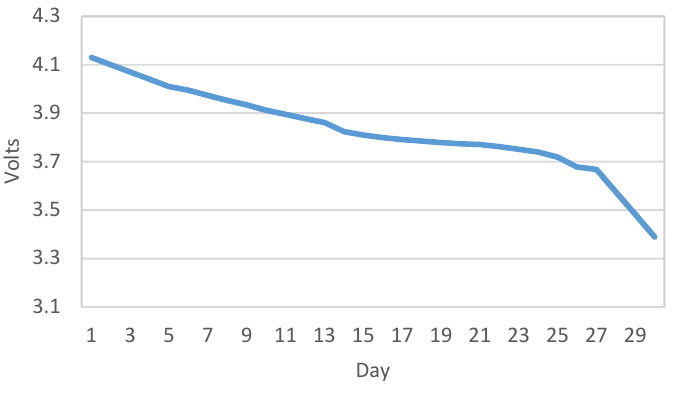
Figure 25. Battery voltage evolution.